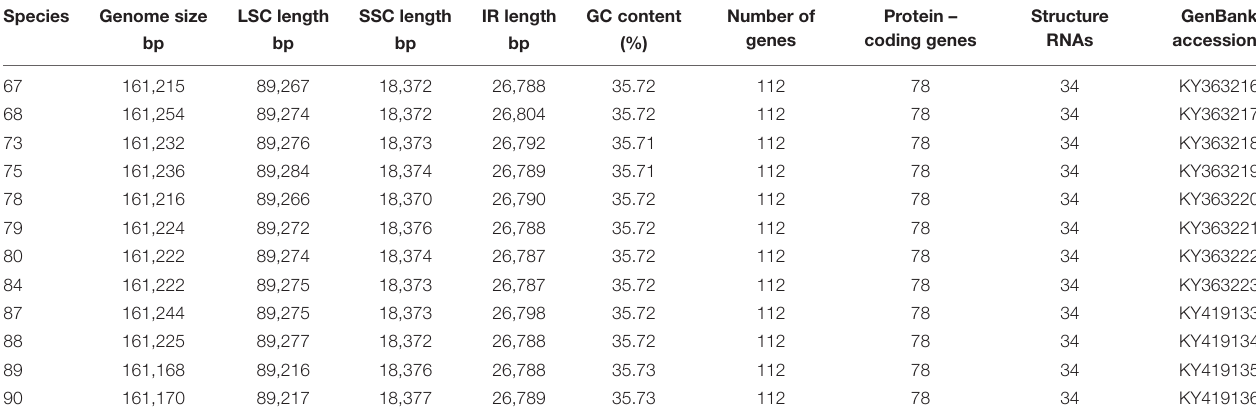
TABLE 2 | Statistic of chloroplast genome features of H. brasiliensis germplasms. Species Genome size